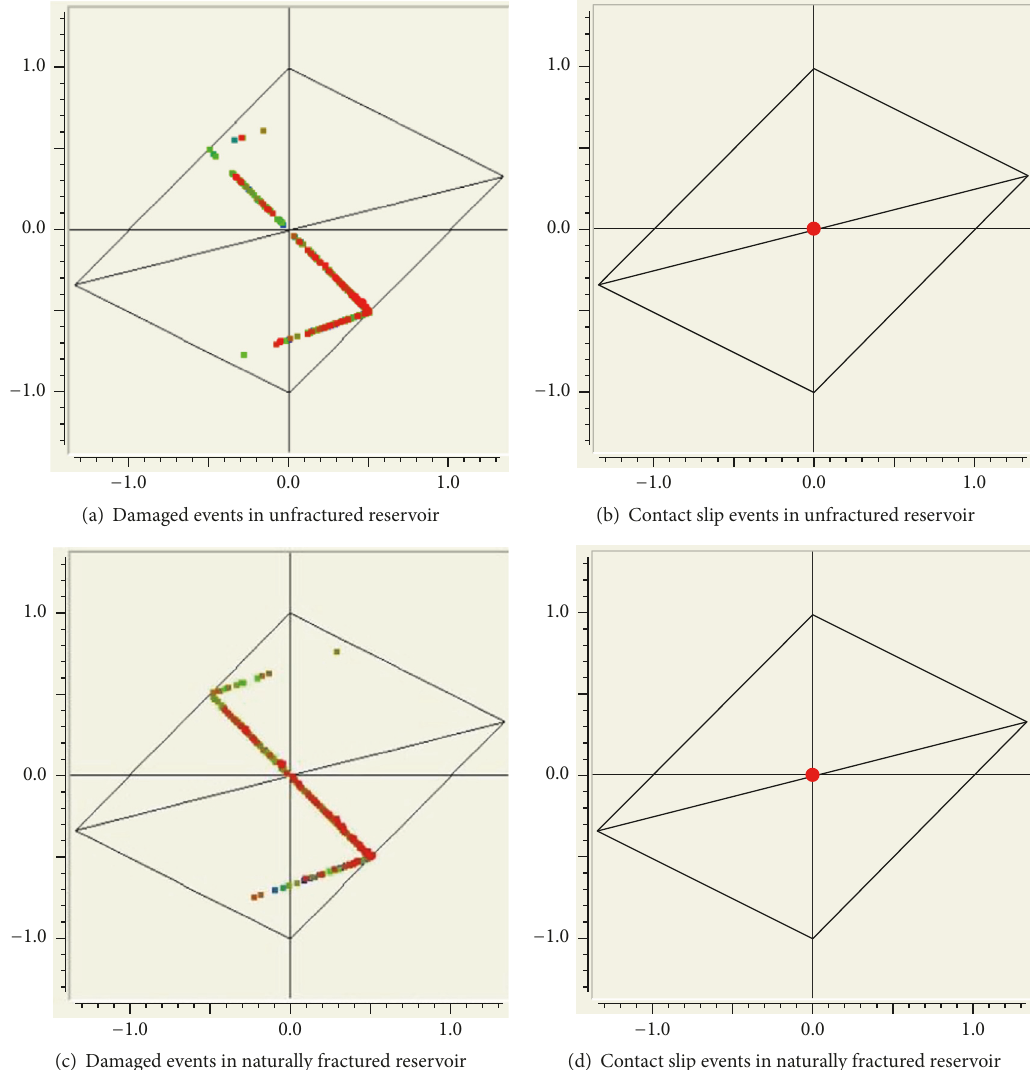
Figure 12: Hudson source type plots for damaged events and contact slip